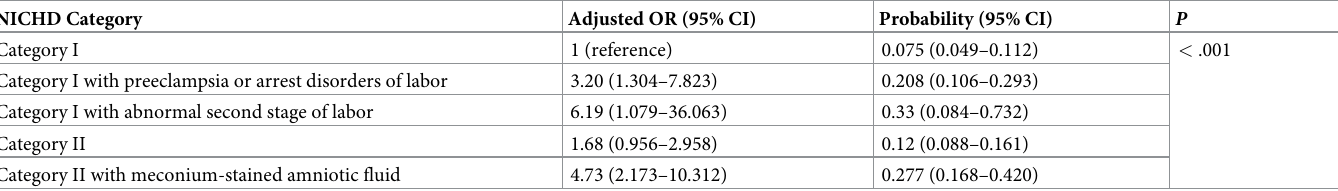
Table 3. Predictive ability of NICHD 3-tier categories I and II alone and combined with significant clinical risk factors for perinatal acidemia. NICHD